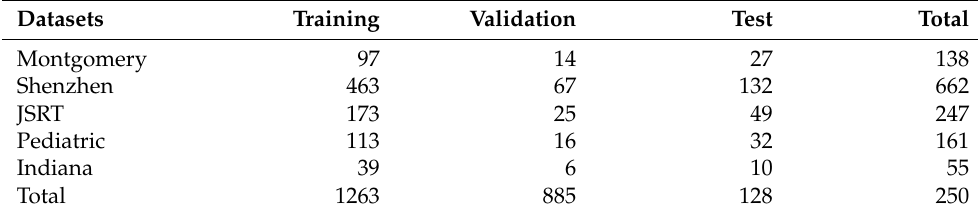
Table 2. The number of images in the training/validation/test set in each dataset. Datasets Training Validation Test Total